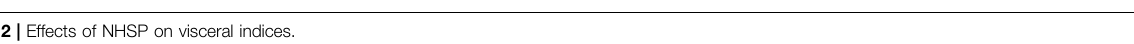
TABLE 2 | Effects of NHSP on visceral